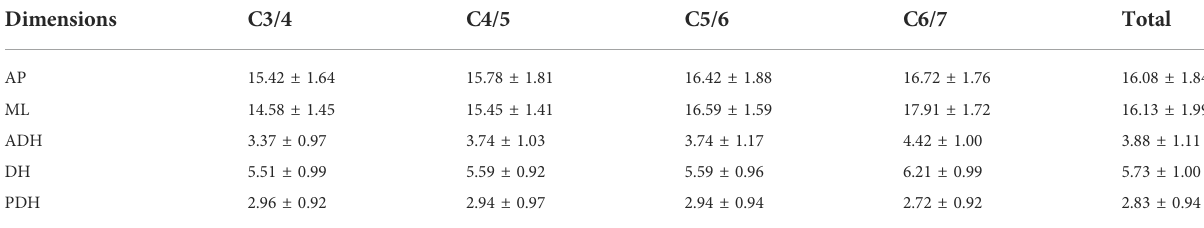
TABLE 2 Dimensions of Linear Parameters ( ‾ X ± S, mm).